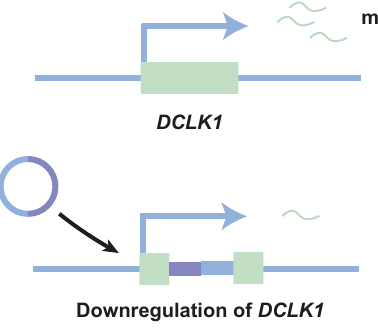
ampli fi cation on eccDNA had signi fi cantly worse 5-year survival outcomes, indicating that the abundance of oncogene-containing eccDNA was associated with tumor aggressiveness. Simulation models showed that tumors carrying a circular amplicon have higher cellular proliferation scores and lower immune in fi ltration